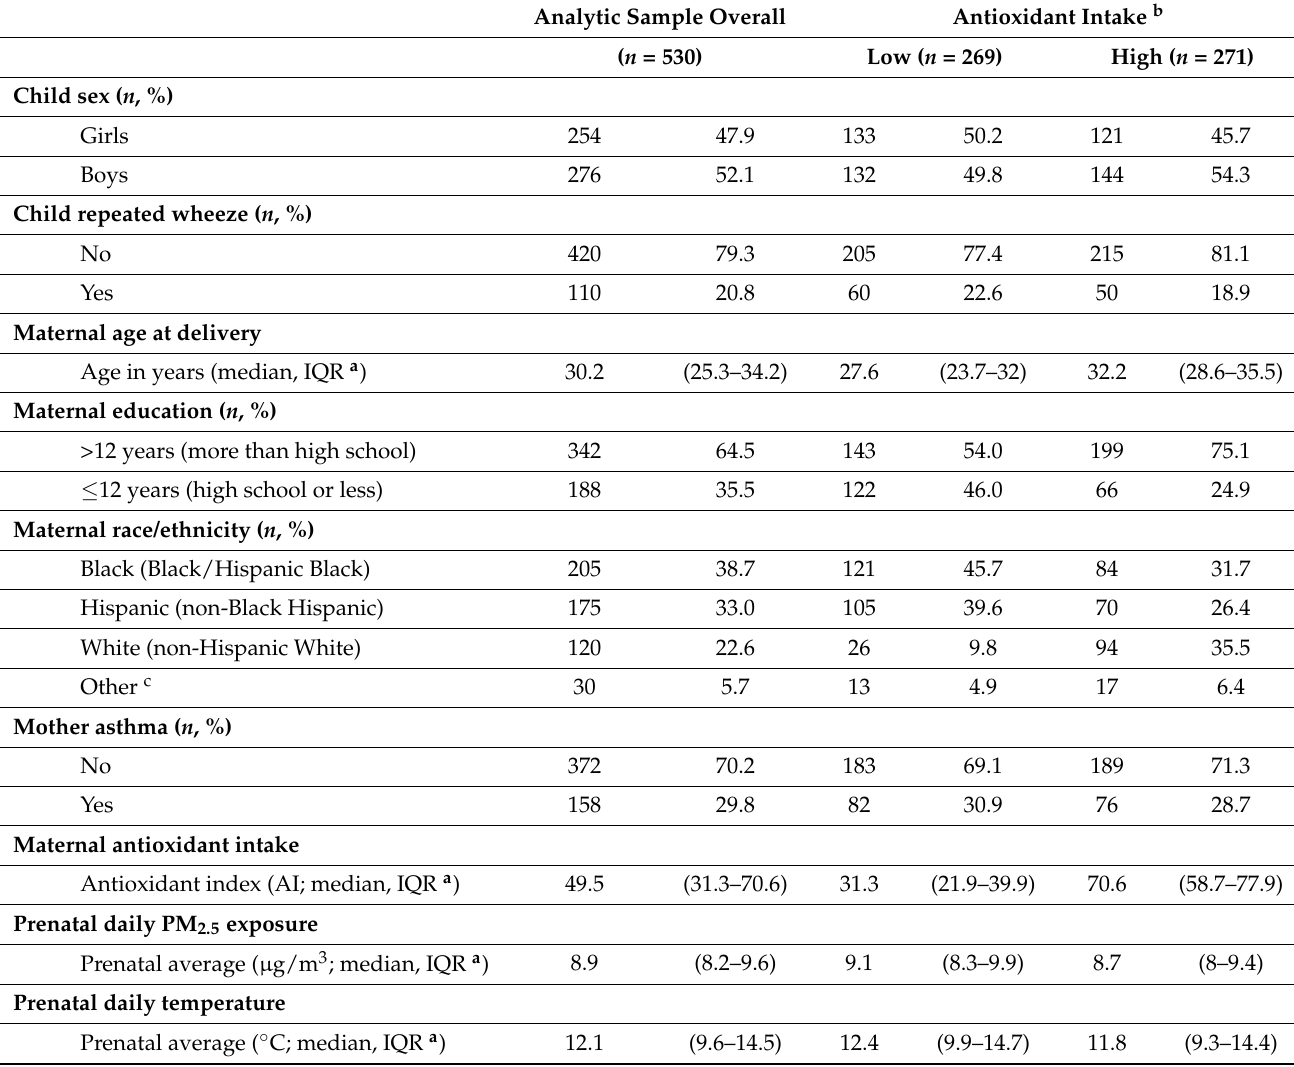
Table 1. Participant characteristics: PRISM